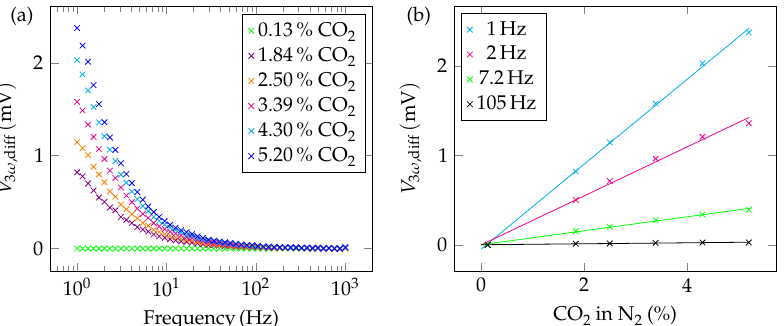
= 0%CO 2 ) = 0%CO 2 ) b (cid:98)